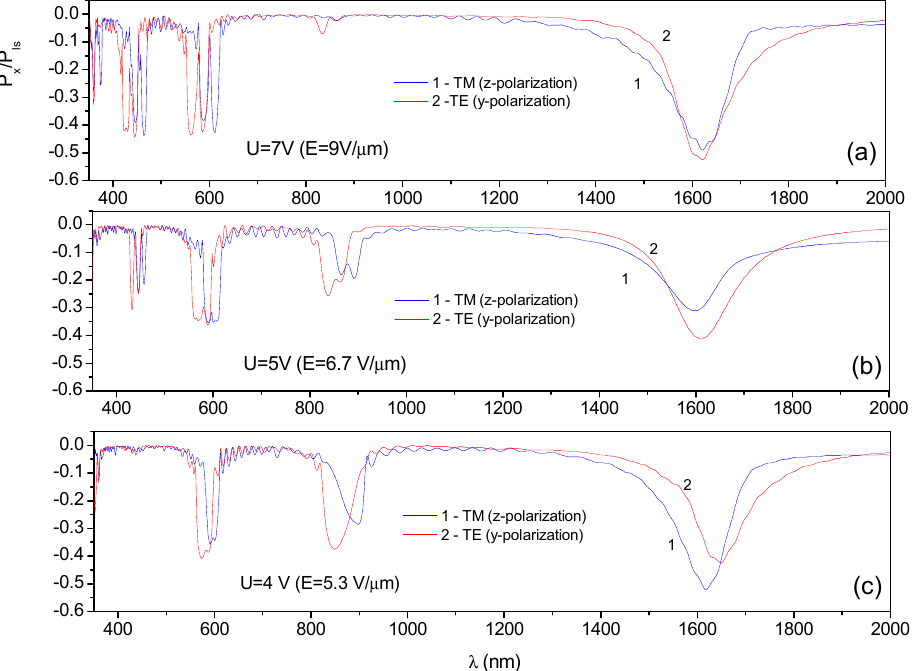
Figure 6. Spectra of the reflected light (the ratio of the reflected light flux (P x ) to the magnitude of the flux from light source (P ls ), calculated using the x -components of the Poynting vectors at the lines of the sensor and light source, Figure 3), at different magnitudes of voltage U applied to the CLC DLH layer: ( a ) 7 V, ( b ) 5 V and ( c ) 4 V. Curves labelled 1 and 2 are for TM- and TE-polarized incident light, respectively.